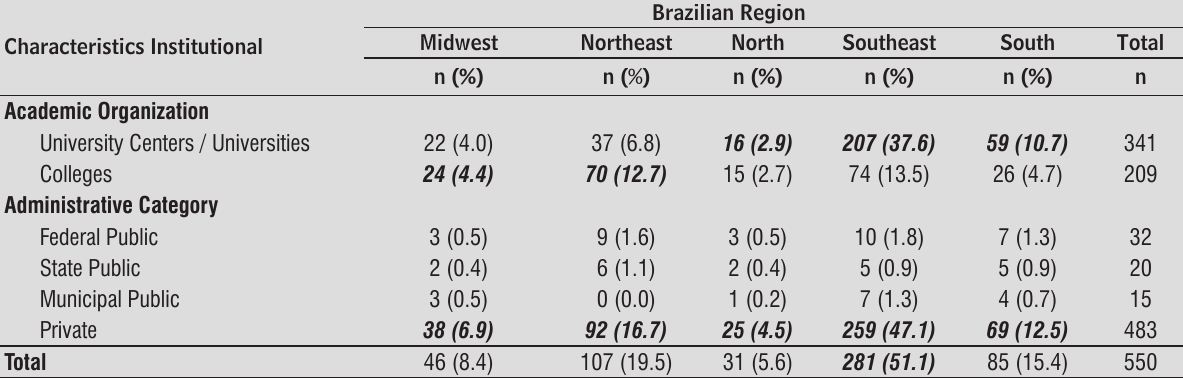
Table 3 - Distribution and percentage of Higher Education Institutions characteristics according to the Brazilian region. Characteristics